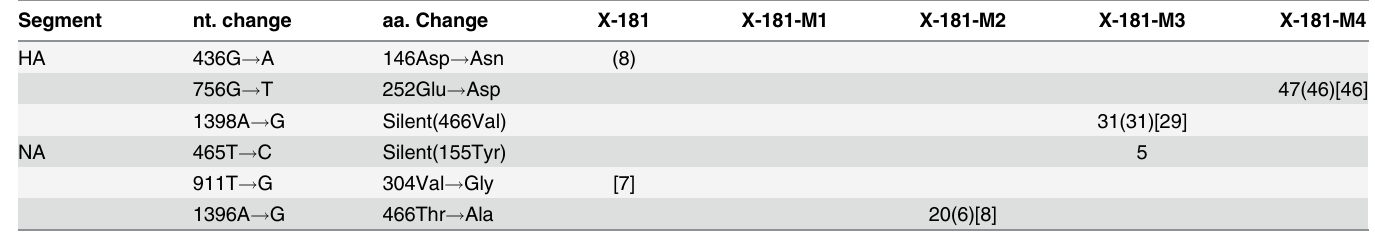
Table 7. Mutation percentages ( (cid:3) 5%) emerged in HA and NA of X-181 viruses passaged in eggs. Notes: The percentages obtained from RNA library followed by HiSeq sequencing are presented without parentheses or brackets. The percentages obtained from RNA library followed by MiSeq sequencing are presented in parentheses. The percentages obtained from DNA library followed by HiSeq sequencing are presented in brackets. These mutation percent- ages were calculated per comparison with the corresponding expanded progenitor. (See accession numbers in Materials and Methods.) aa: Amino-acid, nt: